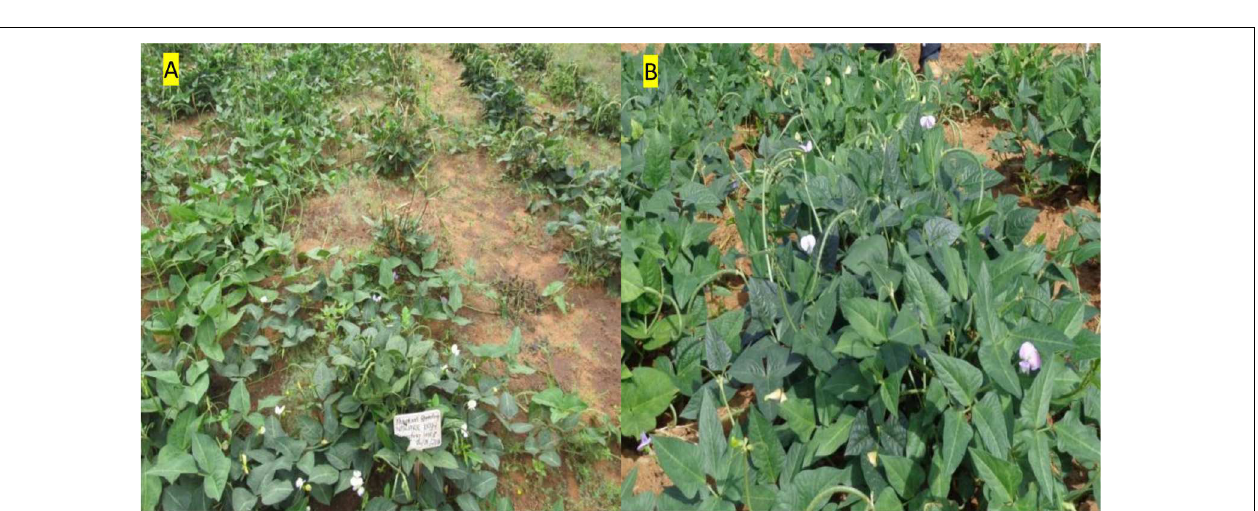
31 cm ( Table 5 ). Bira mutants induced with 300 Gy produced longer pod size (30 cm) ( Table 6 ). Relatively heavier pod size (4003 g/plant) was recorded for Bira at 300 Gy ( Table 4 ). At the M4, Bira had pod size measured at 325 g/plant at 300 Gy. Notably